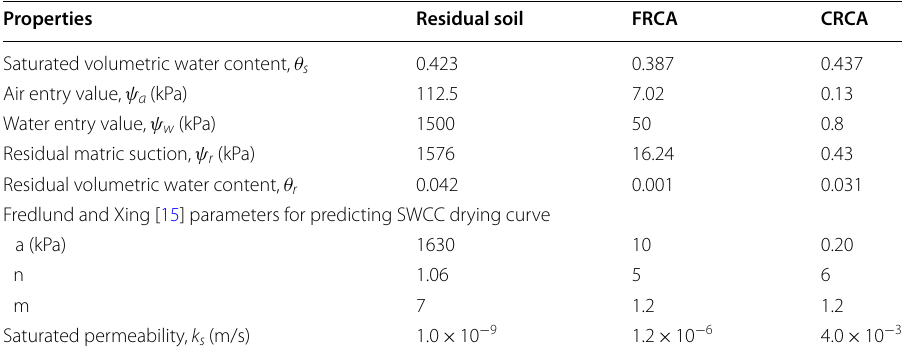
Table 3 Hydraulic properties of residual soil, fine RCA, and coarse RCA